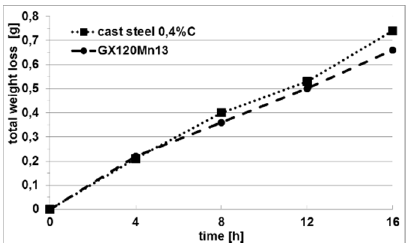
Figure 1. Abrasive wear response of surface-hardened Hadfield cast steel vs. carbon cast steel containing 0.4% C [own research].